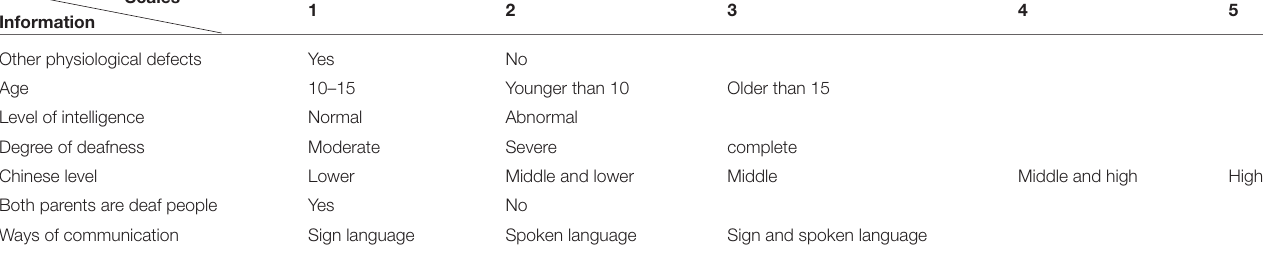
TABLE 2 | Questionnaire concerning the background information of the DHH students. Information